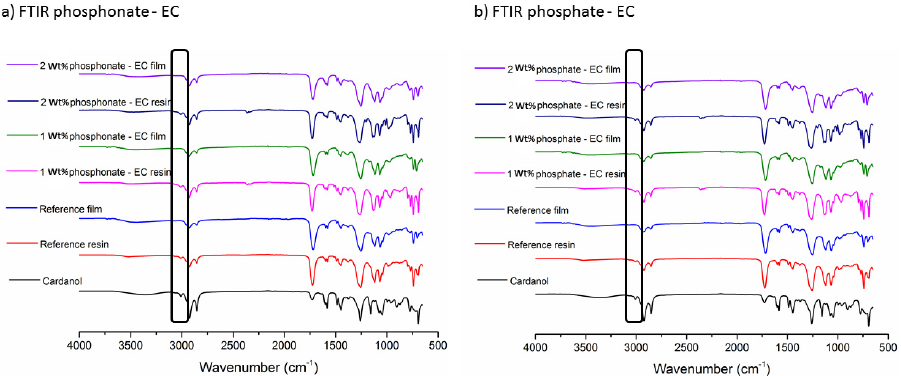
Figure 3. FTIR spectra of cardanol, alkyd resins and alkyd resin films with ( a ) PO 3 CR and ( b ) PO 4 CR .